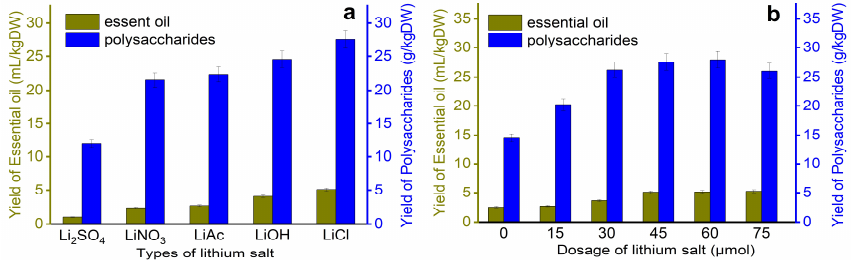
Figure 2. Screening and amount of lithium salt; a : the effect of different types of lithium on the yield of essential oil, b : the effect of the amount of lithium on the yield of essential oil.